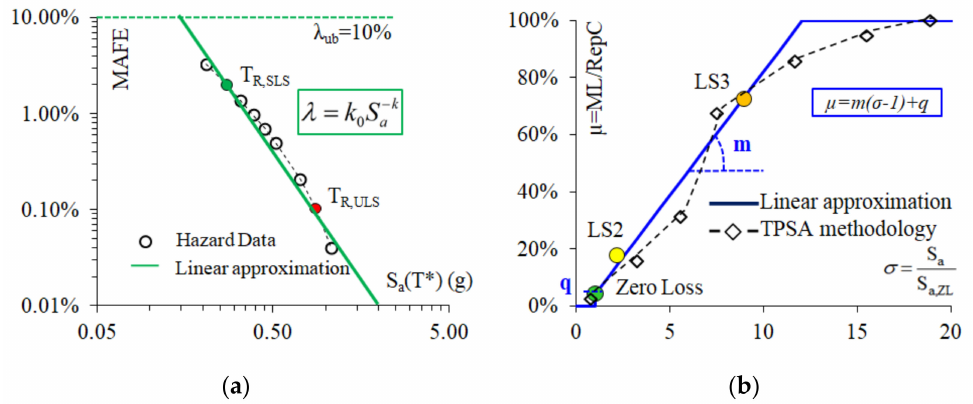
Figure 1. Assumptions of the proposed simplified procedure [4]: ( a ) hazard curve linear approxima- tion and ( b ) expected loss vs. IM